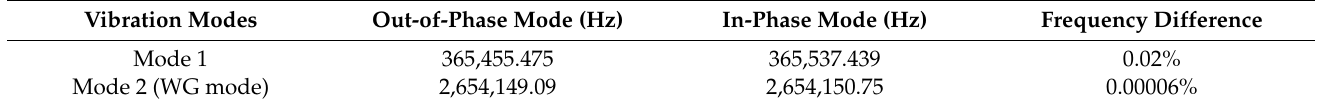
Table 5. Differences in resonant frequencies of a 2-DoF electrostatically coupled BAW disk resonator system operated at different vibrational modes obtained by FEM simulation in